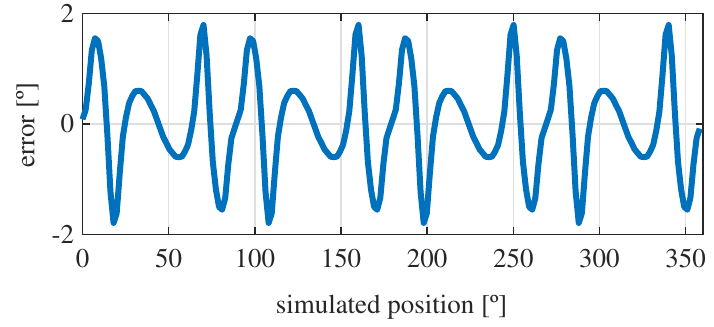
Figure 9. Full pitch four-slot skewed resolver position error.